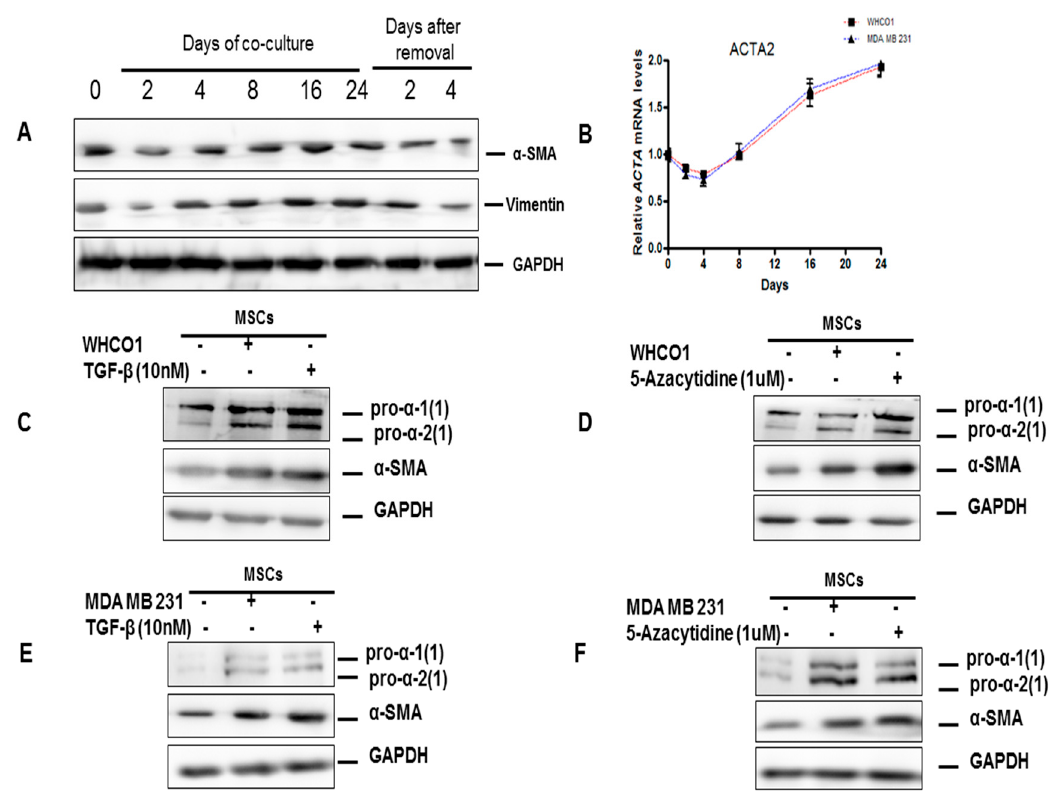
Figure 3. Cancer cells trigger MSCs differentiation into tumor associated fibroblasts via the transforming growth factor- β (TGF- β ) /Smad signaling pathway. For the co-culture experiments cells were co-cultured in 6-transwell plates (size of pore: 0.4 µ m, Polycarbonate membrane, Costar, Corning, Cambridge, MA, USA). Mesenchymal stem cells (5 × 10 5 cells) were cultured in the upper insert and cancer cells (WHCO1 and MDA MB 231) (5 × 10 5 cells) were cultured in the lower compartment. Empty inserts were used for the control group (no cells) and a mixture of MSCs medium and cancer cell medium (1:1) was used. Medium was changed every 3 days for longer incubation periods and fresh TGF- β and reagents were added. TGF- β and all reagents were added to the media to the final concentrations as shown. At specific time points or at the end of the experiment, cells (cancer cells and MSCs) were harvested and used in various analyses. ( A ) Western blot analysis of lysates from MSCs co-cultured with WHCO1 cells for 24 days showing α -smooth muscle actin ( α -SMA) and vimentin protein levels. Glyceraldehyde 3-phosphate dehydrogenase (GAPDH) was used as a loading control. ( B ) Real time quantitative reverse transcription polymerase chain reaction (RT-qPCR) analysis was performed to assess the expression of Actin, alpha2, smooth muscle, aorta (ACTA2) ( α -SMA gene) in MSCs co-cultured with WHCO1 and MDA MB 231 cancer cells over a 24 day period; ( C , D ) western blot analysis of lysates from MSCs co-cultured with WHCO1 cells for 16 days or after the addition of 10 nM TGF- β ( C ) or 1 µ M 5-azacytidine ( D ) for 48 h showing the expression of type I collagen and α -SMA; ( E , F ) western blot analysis of lysates from MSCs co-cultured with MDA MB 231 cells for 16 days or after the addition of 10 nM TGF- β ( E ) or the addition of 1 µ M 5-azacytidine ( F ) for 48 h showing the expression of type I collagen and α -SMA.